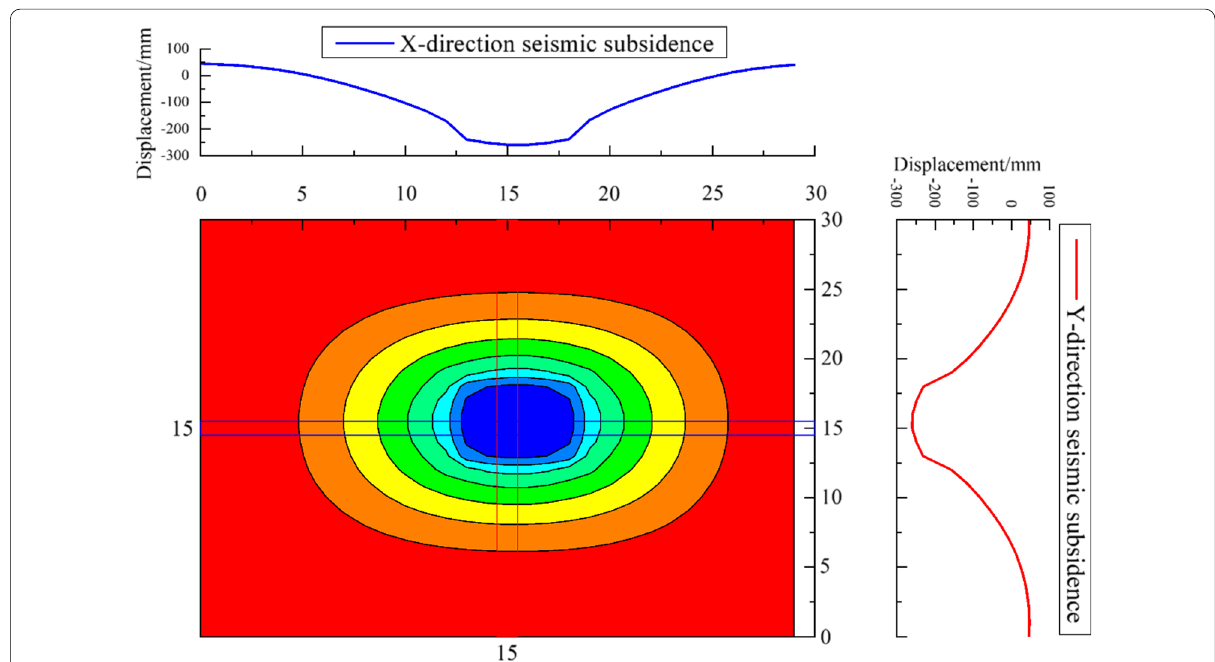
Fig. 10 Seismic subsidence of ground surface due to 0.40 g El Centro ground motion (full view)